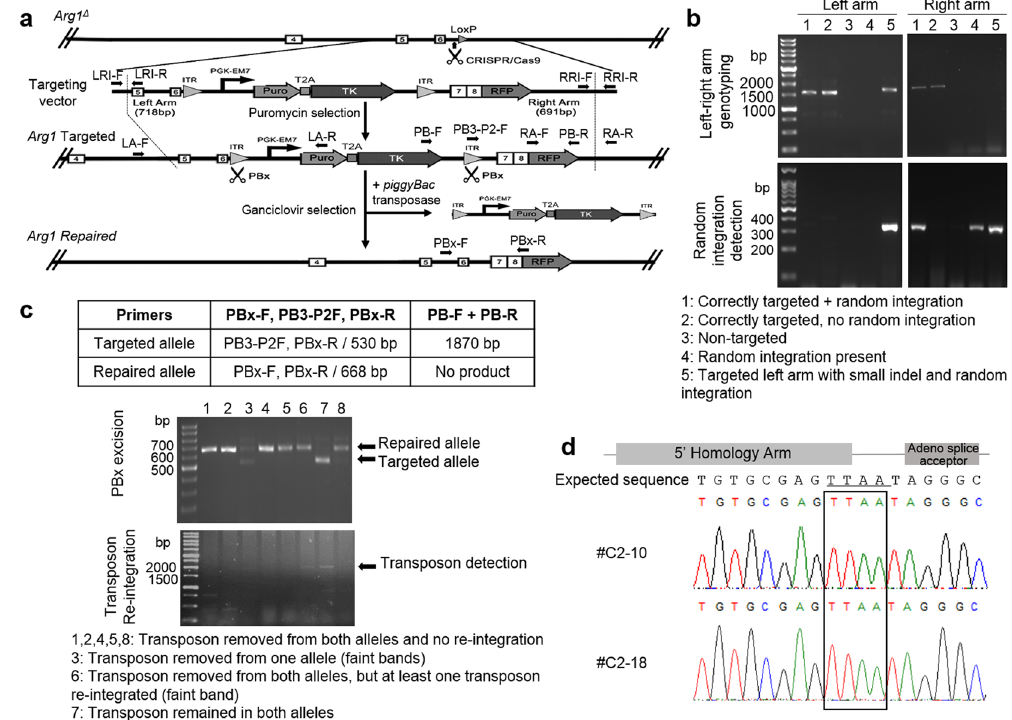
Figure 3. Reincorporation of Arg1 exons 7 and 8 via homology-directed repair. ( a ) The experimental strategy for precise genome modification using CRISPR/Cas9 and piggyBac transposon methodology. Arrows indicate primers for PCR-based screening to confirm the selected clones. The remnant LoxP left from the initial Cre- excision of exons 7 and 8 would be removed upon targeting vector integration. PBx, piggyBac transposase; T2A, viral sequence for ribosomal skipping; Puro, puromycin; ITR, inverted terminal repeat; TK, thymidine kinase. ( b ) Representative gel images of puromycin-resistant iPSC colonies screened for correctly targeted clones. Each homology arm was amplified independently by PCR. Amplicon sizes of the left and right arm were 1530 and 1660 bp, respectively, while random integration should yield a product of ≈ 300 bp. ( c ) PCR-based genotyping of alleles after piggyBac excision. Upper panel shows primer combination to uniquely identify different alleles. Lower panel shows a representative gel of different banding patterns and corresponding genotypes. Amplicon sizes of the repaired and targeted alleles were 668 bp and 530 bp, respectively. ( d ) Footprint analysis by sequencing. Sequences in transposon-free repair clones indicating the exact repair after transposon excision. TTAA target sites are